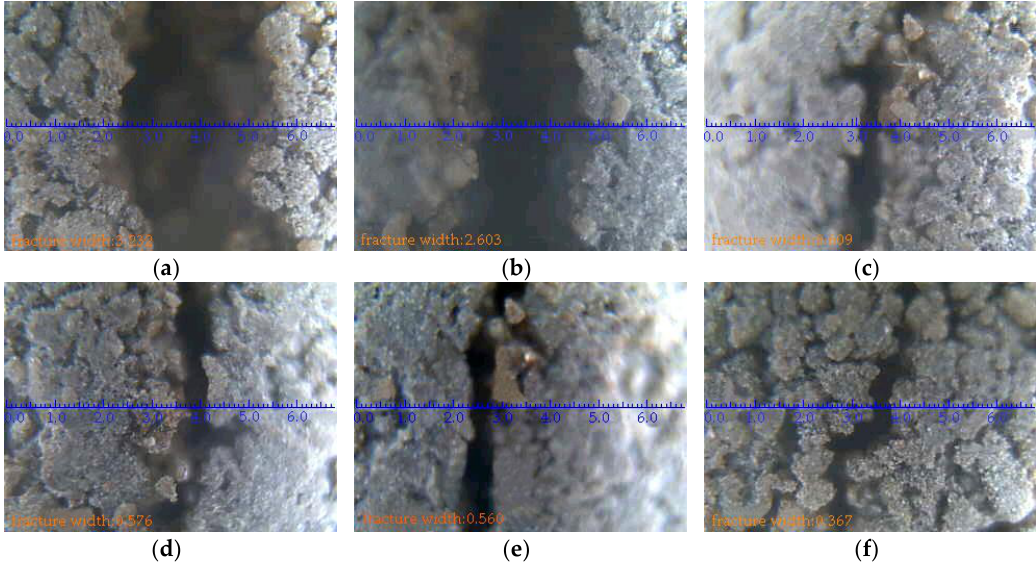
Figure 15. GSF ④ evolution vs. CPMD: ( a ) Aligned pillars; ( b ) CPMD of 10 m; ( c ) CPMD of 30 m; ( d ) CPMD of 40 m; ( e ) CPMD of 50 m, and ( f ) CPMD of 80 m.